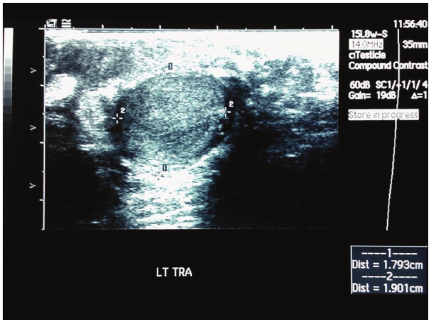
Figure 1: Scrotal US scan at the emergency department. Right-sided solid paratesticular mass.